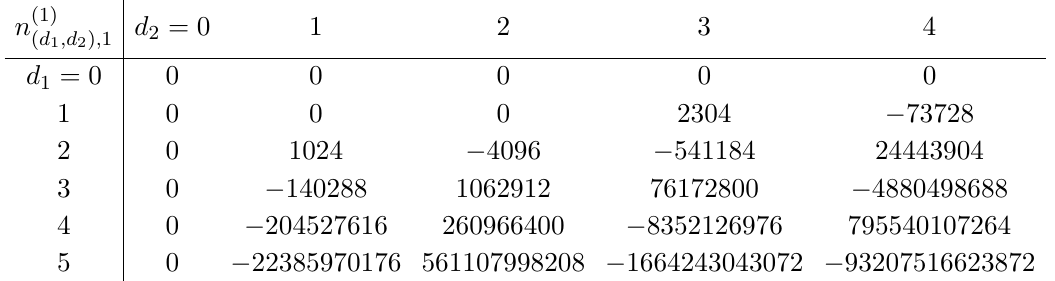
Table 11 . Genus 1 torsion refined Gopakumar-Vafa invariants with Z 2 charge 1